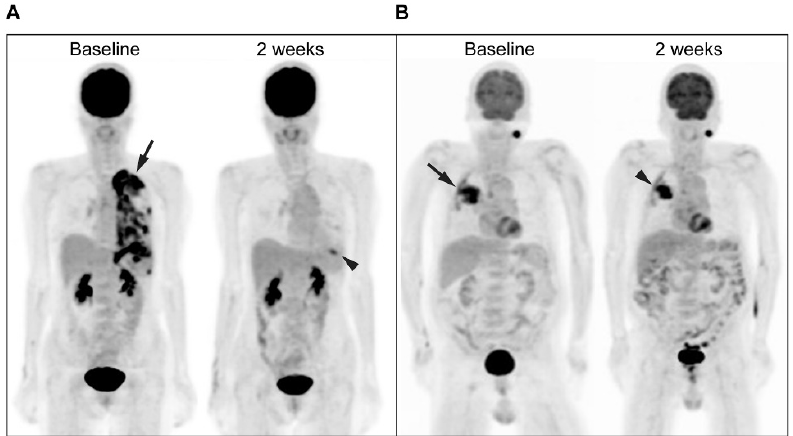
Figure 2. Illustrative images of 18 F-FDG PET responses. ( A ) Maximum-intensity projection (MIP) 18 F-FDG PET images at baseline and after 2 weeks of gefitinib treatment of a 58-year-old woman with stage IV lung adenocarcinoma and mutant EGFR (exon 19 del) showing marked 18 F-FDG response visually. The SUL max of the single hottest lesion decreased from 10.7 (left upper pleura, arrow) to 4.10 (lingula of left lung, arrowhead), with a Δ SUL of − 61.5% and a PMR based on PERCIST 1.0. She achieved PR at 3 months. ( B ) MIP 18 F-FDG PET images at baseline and after 2 weeks of gefitinib treatment of a 78-year-old man with stage IV lung adenocarcinoma and mutant EGFR (L858R) showing SMD (nMR) based on PERCIST 1.0. The SUL max of the single hottest lesion decreased from 9.37 (right upper lobe pulmonary mass, arrow) to 8.91 (the same lesion, arrowhead), with a ∆ SUL of − 4.90%. There was also an incidental left parotid tumor. He had PD (a new left adrenal metastasis) at 3 months. Table 3. Multivariate analysis of parameters and association with PFS ( n =